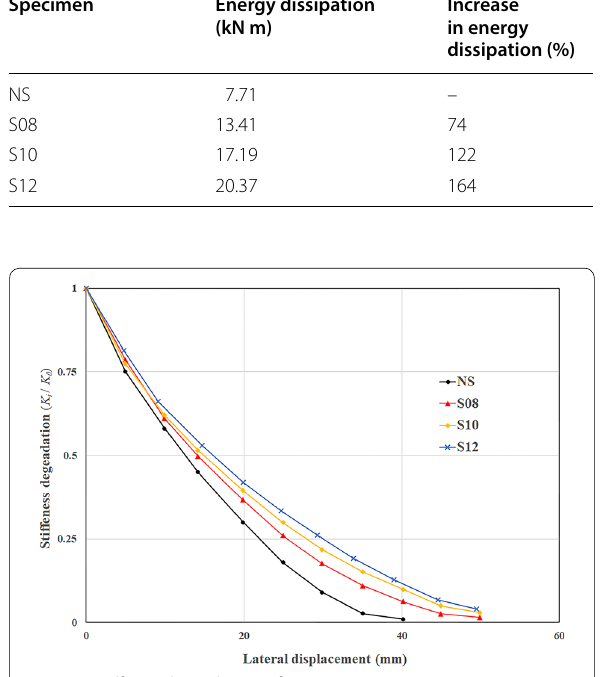
Fig. 10 Stiffness degradation of